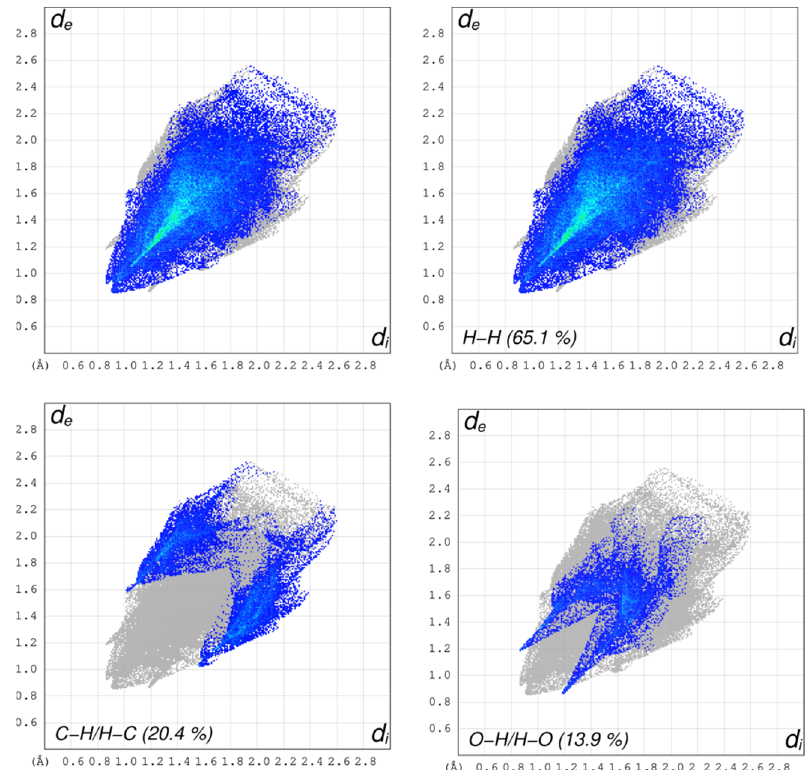
Figure 8. Fingerprint plots for the title